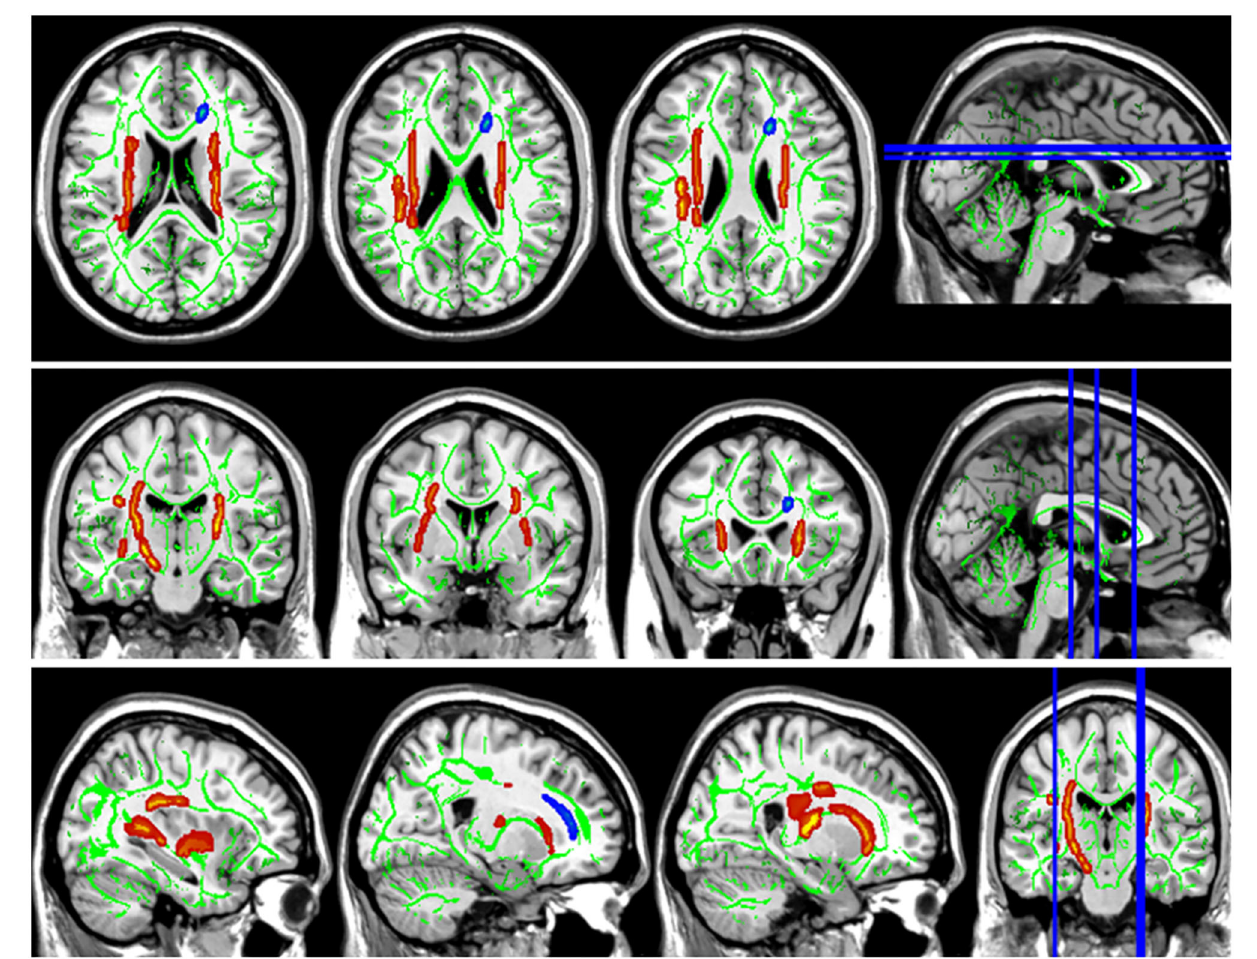
FIGURE 1 | Fractional anisotropy (FA) results of tract-based spatial statistics (TBSS). The background map was constructed by the mean FA skeleton (green) overlaid on the Montreal Neurological Institute (MNI) template. The red voxels represent values increase, and the blue voxels represent a decrease. Group differences in FA. The FA values of left acoustic neuroma (LAN) and right acoustic neuroma (RAN) patients decreased in the minor forceps, while the FA value in the bilateral corticospinal tract and the left superior longitudinal fasciculus increased compared to the healthy control (HC) group.